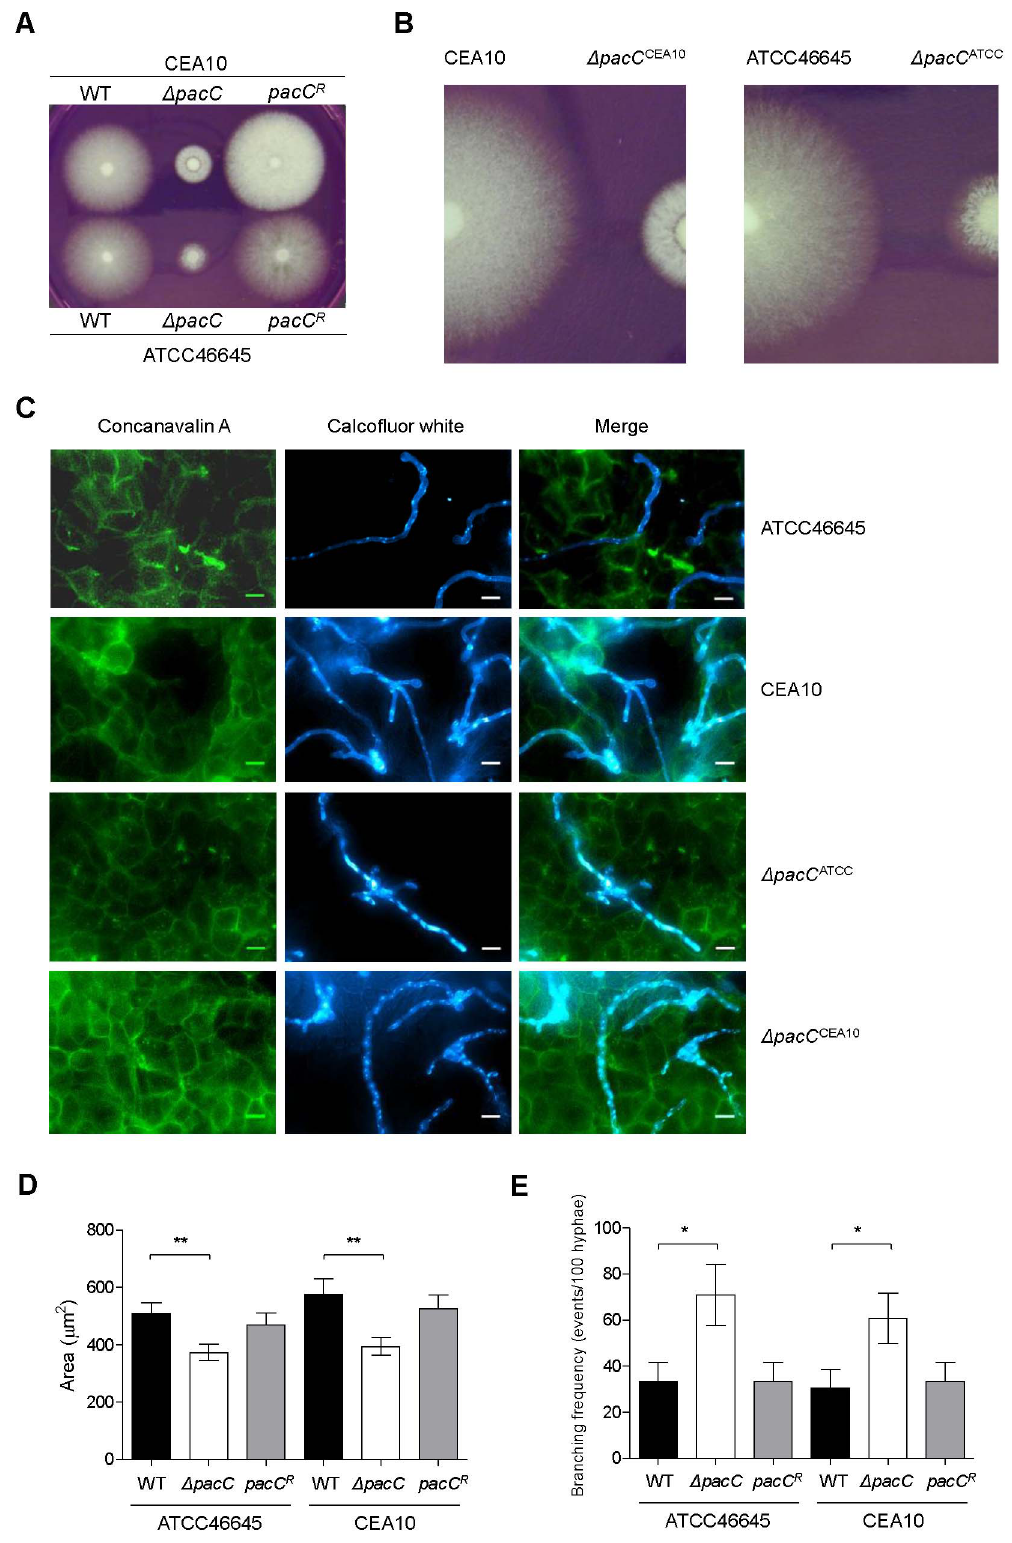
Figure 1. Impact of pacC deletion upon A.fumigatus growth. (A and B) Colonial growth phenotypes on supplemented DMEM, 48 hr of growth, 10 3 conidia. (C) Immunofluorescence-mediated visualisation of A. fumigatus growth in co-culture with A549 epithelial cells, 16 hours, supplemented DMEM pH 7.4. Fungal cells are labelled with calcoflour white and host cells are labelled with FITC-conjugated concanavalin A, 10 5 spores/ml, 200 6 magnification. (D) Quantitation of cell size ( m M 2 ) at 16 hr of co-culture with A549 cells, 10 4 spores/ml, growth conditions as for panel C. (E) Branching frequency of A. fumigatus hyphae, 10 4 spores/ml, growth conditions as for panel C. doi:10.1371/journal.ppat.1004413.g001 PLOS Pathogens | www.plospathogens.org